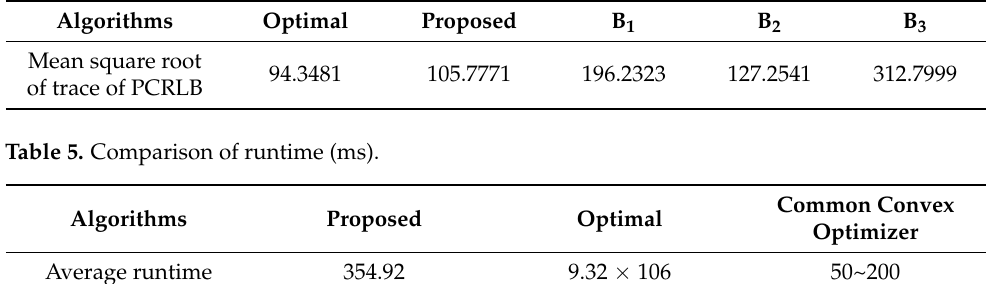
Table 4. Comparison of the performance when | α k | 2 / σ v 2 = 1 / 100.